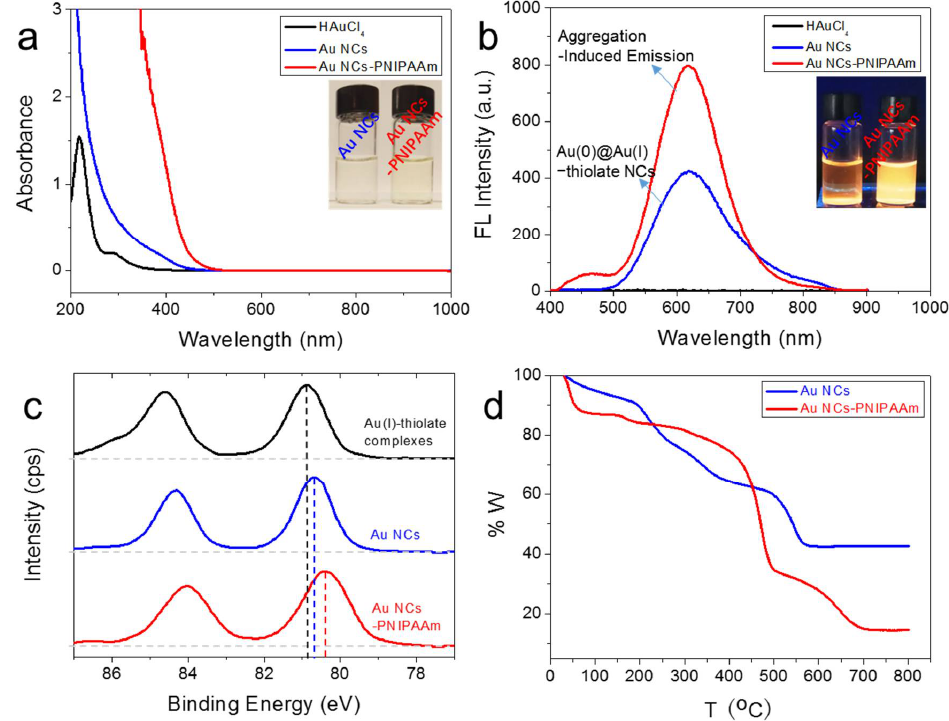
Figure 1. ( a ) UV-vis absorption and ( b ) photoemission spectra of HAuCl 4 , Au NCs, and Au NCs- PNIPAAm in aqueous solution (λ ex = 365 nm, λ em = 610 nm). (Insets) Digital photos of luminescent Au NCs and Au NCs-PNIPAAm under ambient light and UV light. ( c ) Au 4f XPS spectra of Au-thiolate complexes, luminescent Au NCs, and Au NCs-PNIPAAm. ( d ) TGA curve of Au NCs and Au NCs-PNIPAAm.